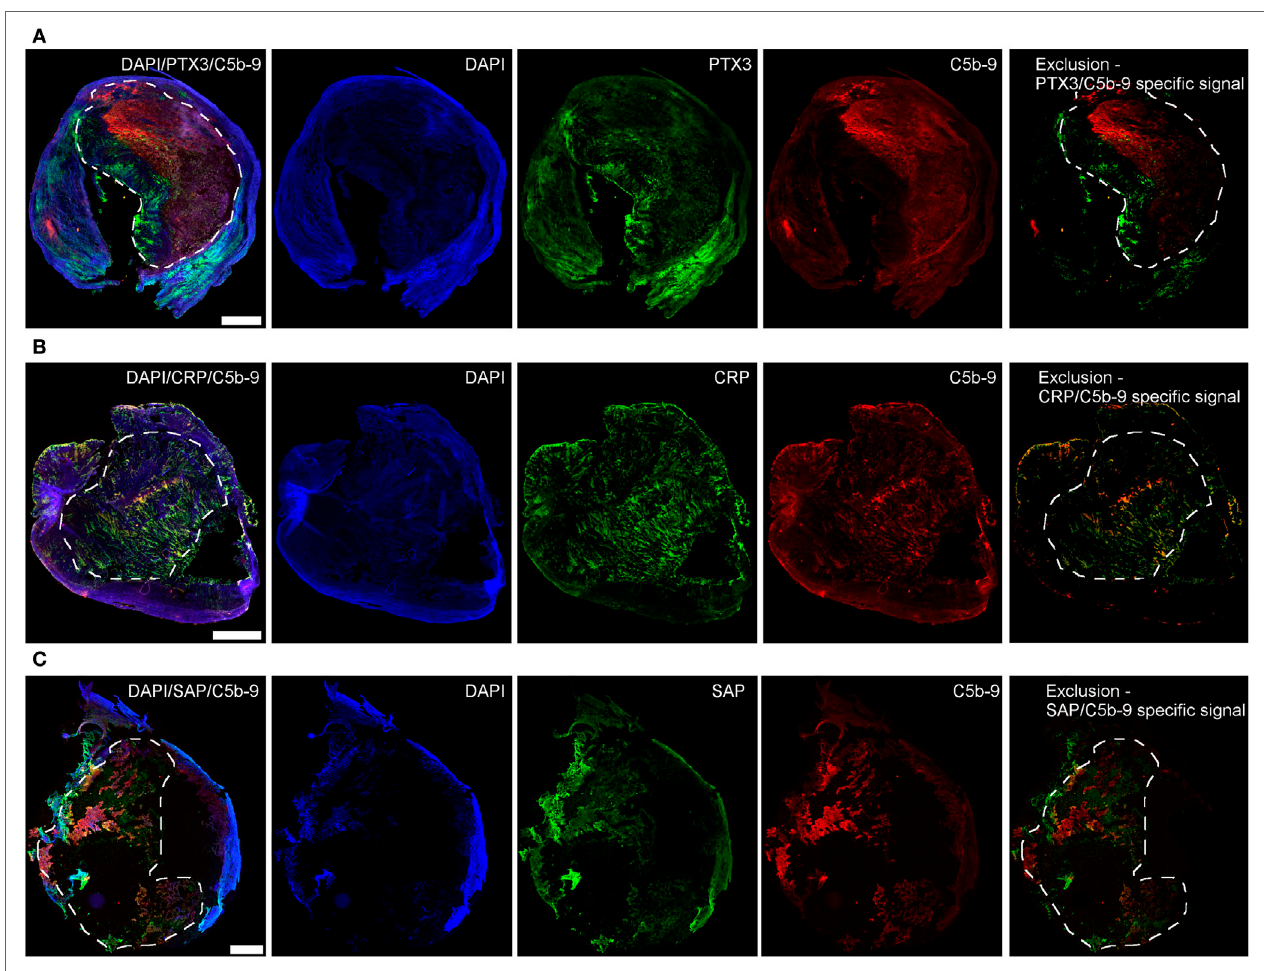
FigUre 6 | Pentraxin 3 (PTX3) (a) , C-reactive protein (CRP) (B) , and SAP (c) are found in human atherosclerotic plaques. PTX3, CRP, and SAP (green) deposited mainly in the necrotic core (dashed areas) where C5b-9 (red) was also mostly found. The exclusion images showed the specific signal for each of the proteins obtained after deletion of the collagen-associated unselective fluorescence. Images are representative of four plaques analyzed per marker. Scale bars = 1